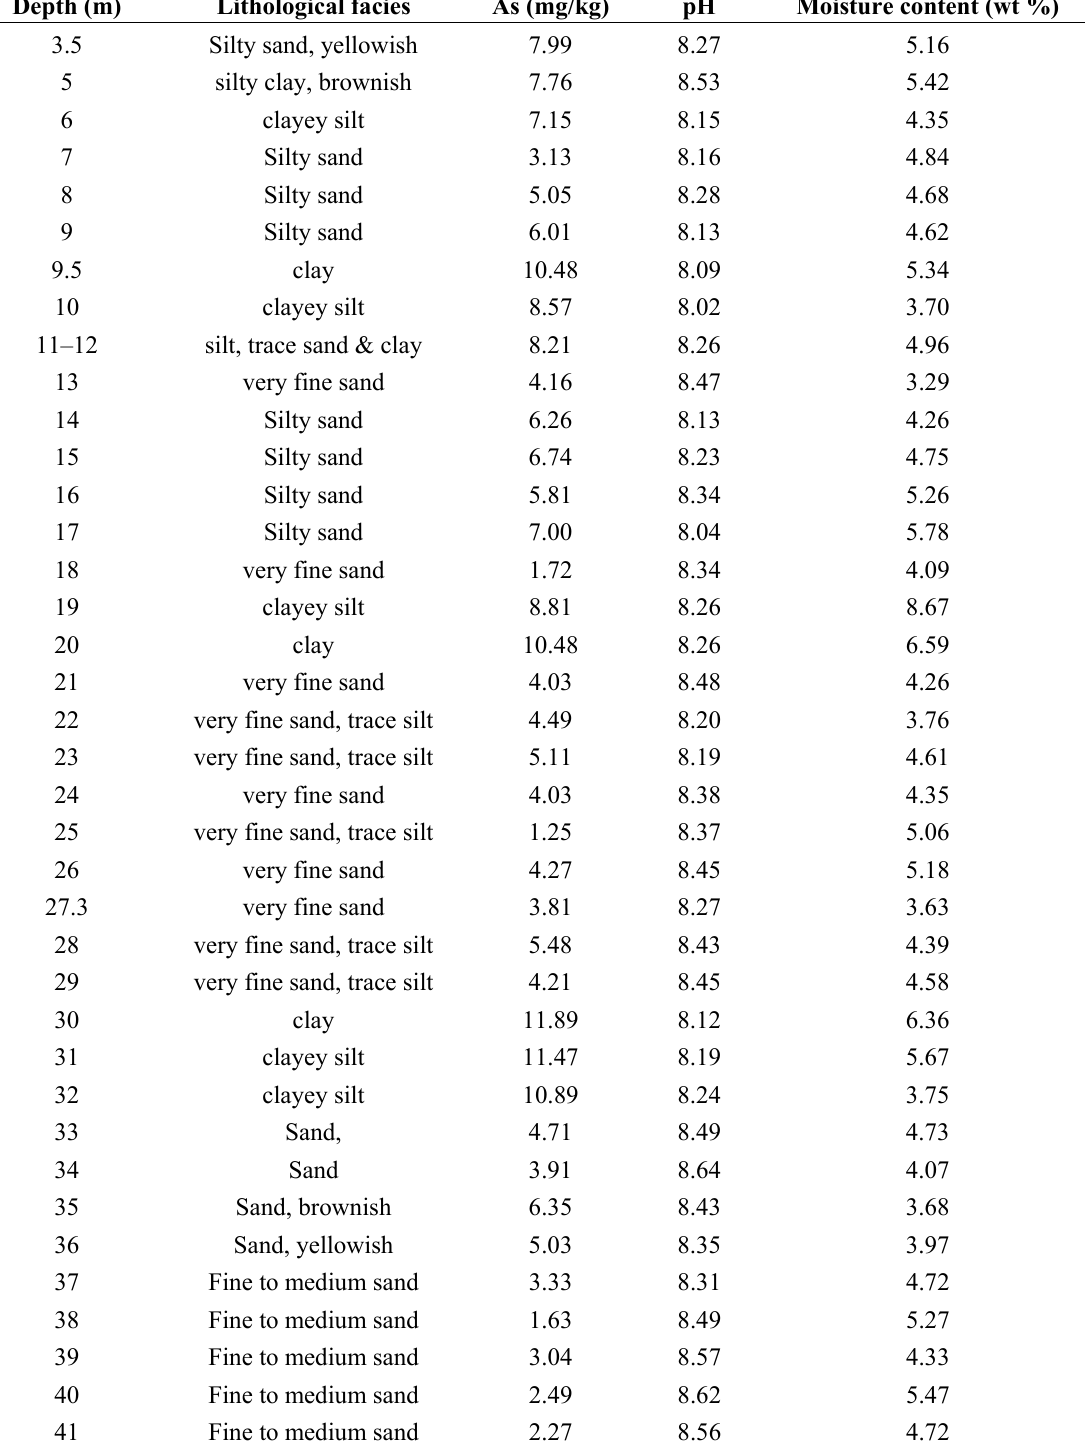
Table A1. Physico-chemical characteristics and arsenic contents in cores of